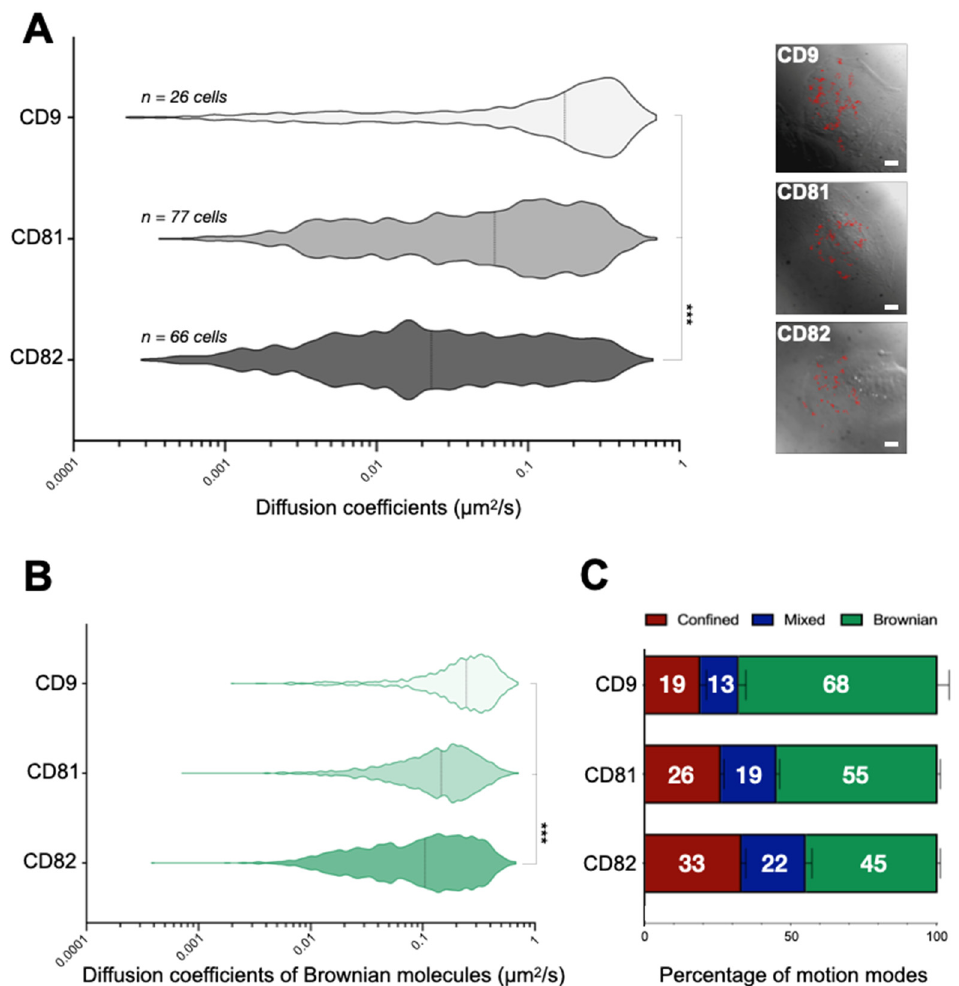
Figure 1. Membrane dynamics of tetraspanins CD82, CD81, and CD9 at the plasma membrane of HB2/CD82 cells. ( A ) Distribution of the apparent diffusion coefficients calculated for all individual tetraspanins molecules analyzed in HB2/CD82 cells. The violin plots were built with 1000 trajectories for each tetraspanin. The dotted lines indicate the median of the populations. The images on the right are examples of DIC images of cells taken after single molecule tracking and some analyzed trajectories are shown in red (scale bars, 5 μ m). ( B ) Distribution of the apparent diffusion coefficients of Brownian tetraspanin molecules analyzed in HB2/CD82 cells. The dotted lines indicate the median of the populations. *** indicate that the difference between the populations is significant with a p value below 0.0001 as determined by the Mann–Whitney U test. ( C ) Histograms representing the percentage of tetraspanin molecules exhibiting Brownian, confined and mixed motion relative to the total number of trajectories. The error bars represent the standard deviation of at least three independent experiments.